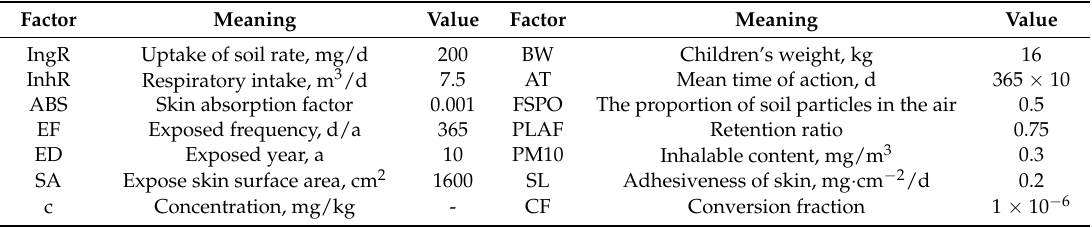
Table 2. Health hazard assessment parameters of Potentially Toxic Elements.